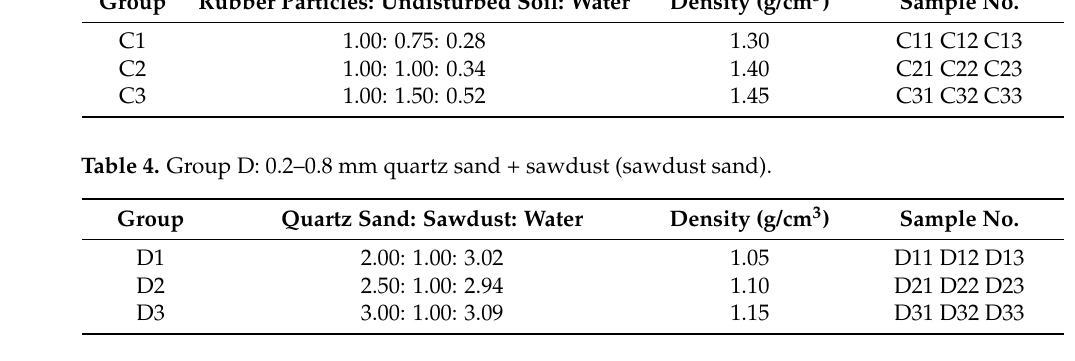
Table 5. Group F: sawdust Kaolin (sawdust Kaolin). Table 3. Group C: rubber particles + undisturbed soil (rubber granular soil). Rubber Particles: Undis- Group turbed Soil: Water